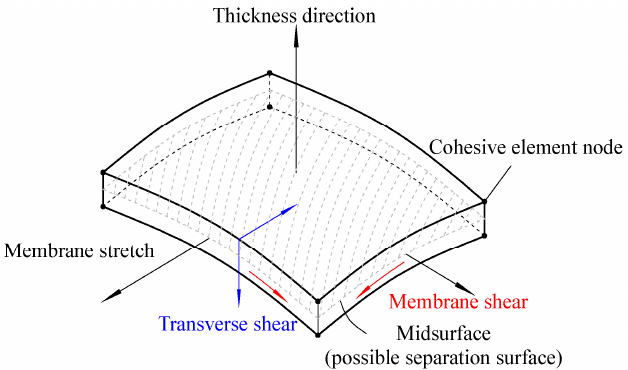
Figure 30. Spatial representation of CH3D8 (eight-node three-dimensional) cohesive element. Reproduced with Creative Common License [240].